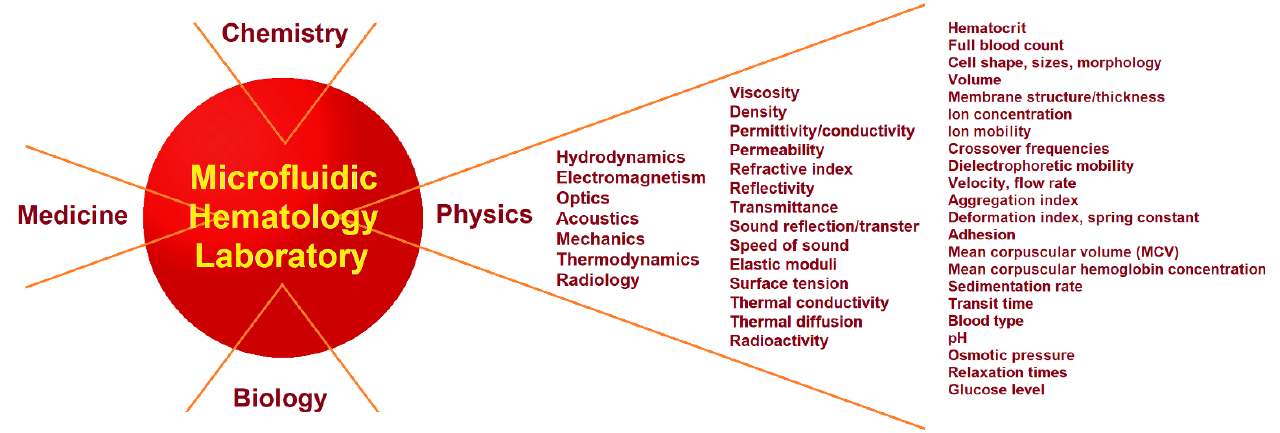
Figure 1. Contribution of physics to a microfluidic hematology laboratory.